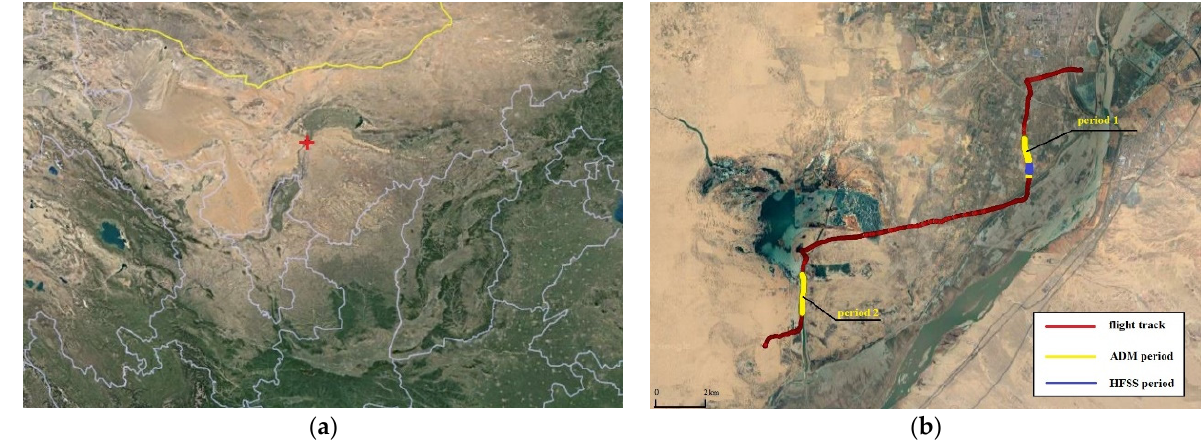
Figure 1. ( a ) The location of the MOSIR ground experiment area (the red cross). The experimental area is in Dengkou County of the Inner Mongolia Autonomous Region, China. ( b ) Satellite image of the experimental area and the flight track of MOSIR in the ground experiment (the red line). The yellow line represents the coverage of ADM data, and the blue one represents the coverage of HFSS data, in which ADM mode is also on.